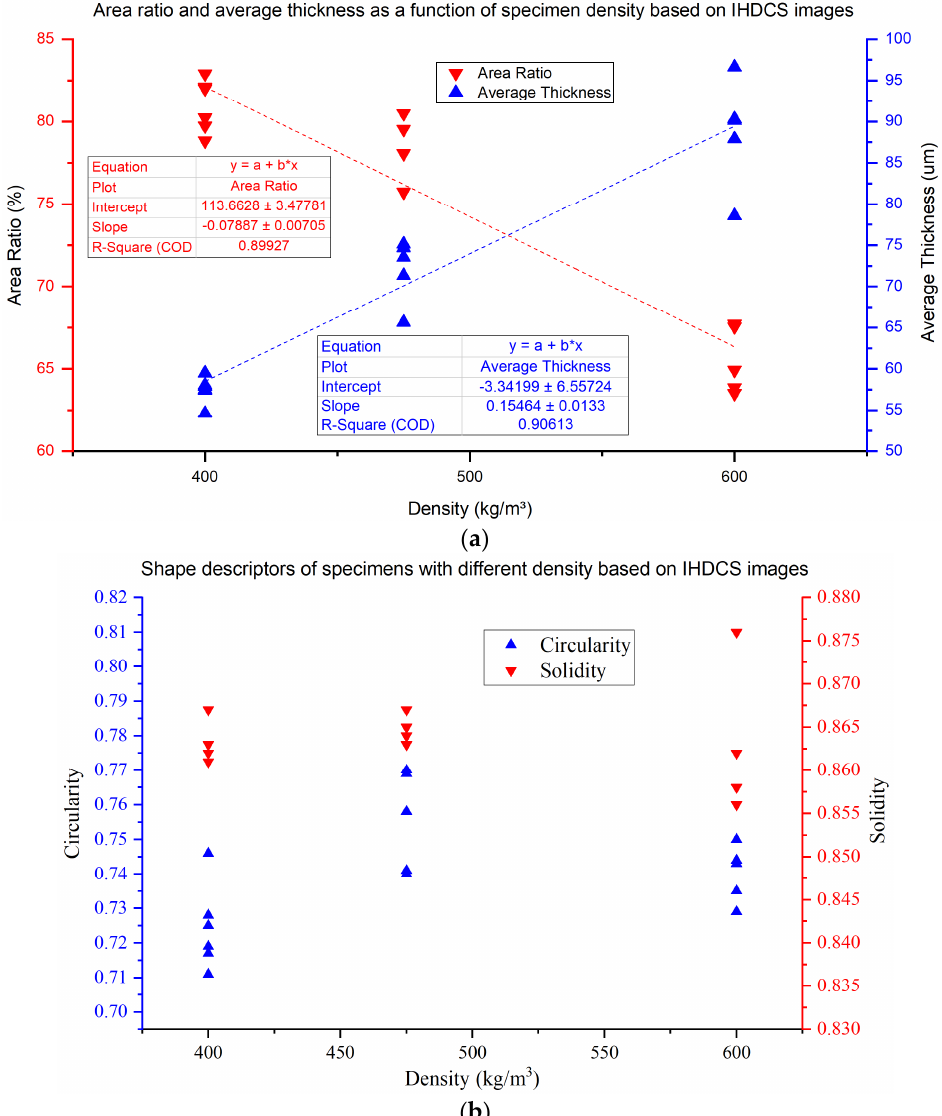
Figure 11. Results of pore characteristic based on IHDC. ( a ) Area ratio and average thickness as a function of specimen density based on IHDCS images. ( b ) Shape descriptors of specimens with different density based on IHDCS images.